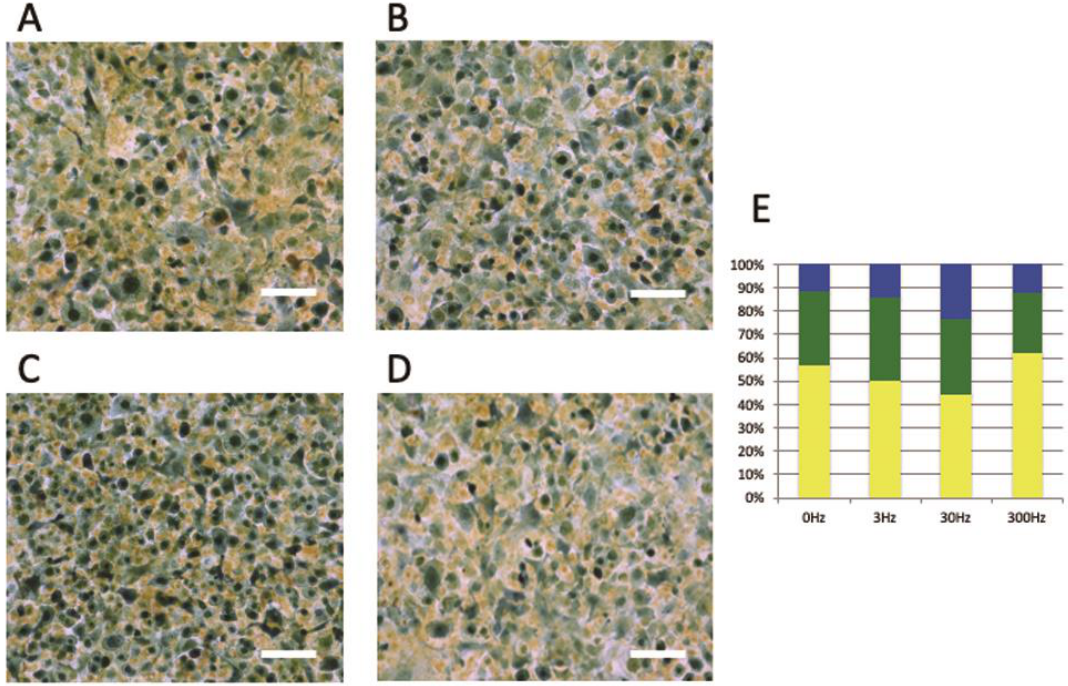
Figure 3. Cell-Clock Cell Cycle Assay. ( A ): 0 Hz, ( B ): 3 Hz, ( C ): 30 Hz, ( D ): 300 Hz, Scale bar = 100 µm, ( E ): Each cell cycle stage is based on the proportions of each color tone out of the total pixel values. Many cells were stained dark blue upon applying vibrations at 30 Hz compared to 0, 3, and 300 Hz. (yellow: G0/G1 stage, green: S/G2 initial stage, dark blue: G2 late stage/M stage).